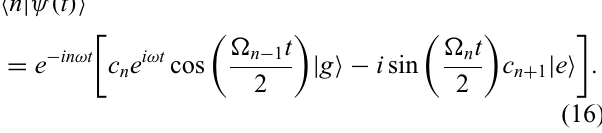
FIG. 1. Probability distribution for “transcoherent” field states that perfectly create coherent atomic states from | g (cid:2) in time t . Also plotted are the (Poissonian) probability distributions for coherent states that are classically used for π/ 2 pulses. The ideal field state distributions approach slightly-number-squeezed coherent states as t decreases and the average energy